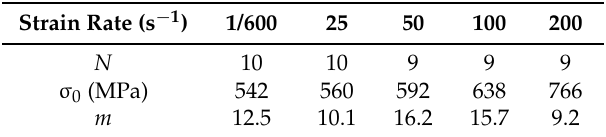
Table 5. Weibull parameters for tensile strength of GFRP under different temperatures.